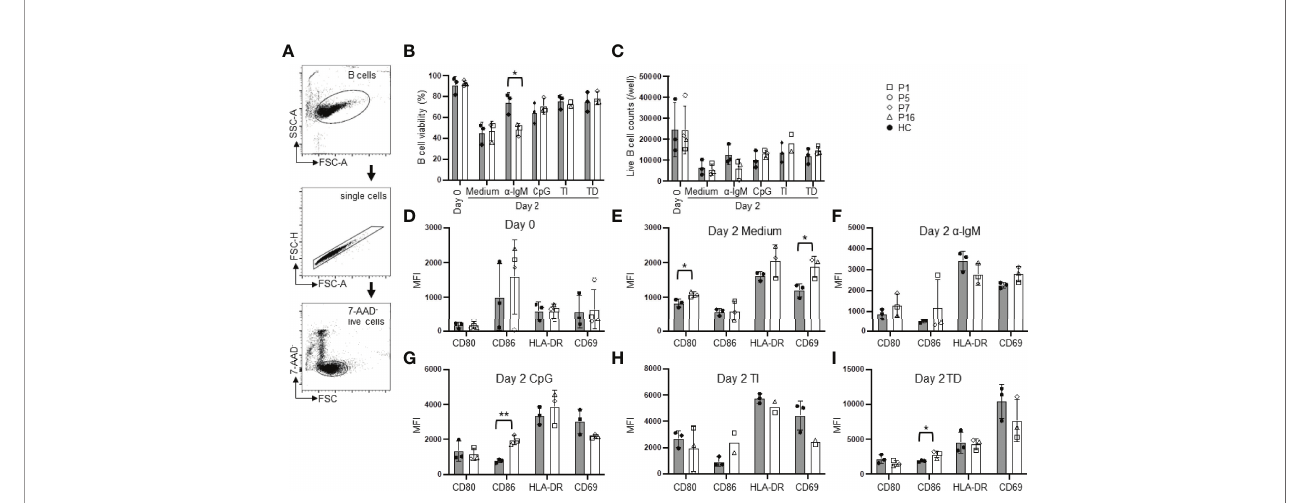
FIGURE 3 | B cells from the patients show reduced survival and altered activation. Puri fi ed naïve B cells were cultured for 2 days in medium alone or in the presence of the indicated stimuli and analyzed for B cell survival and activation. (A) Gating strategy for live cells. (B) B cell viability (%) before (day 0) and after culture (day 2) with medium alone or a -IgM Abs (BCR signal), CpG2006 (TLR9 signal), a -IgM + CpG + IL-2 (T cell-independent stimuli, TI), or SA-CD40L plus IL-4 (T cell- dependent stimuli, TD). (C) Live B cell numbers before (day 0) and after culture. (D – I) Expression levels (mean fl uorescence intensity, MFI) of CD80, CD86, HLA-DR, CD69 on freshly isolated B cells (D) or B cells cultured in medium alone (E) or with the indicated stimuli (F – I) for 2 days. Grey column, HC (n=3-4); Open column, patient (n=3-5). Mean ± SD is shown. * p < 0.05; ** p < 0.01 (unpaired t-test).